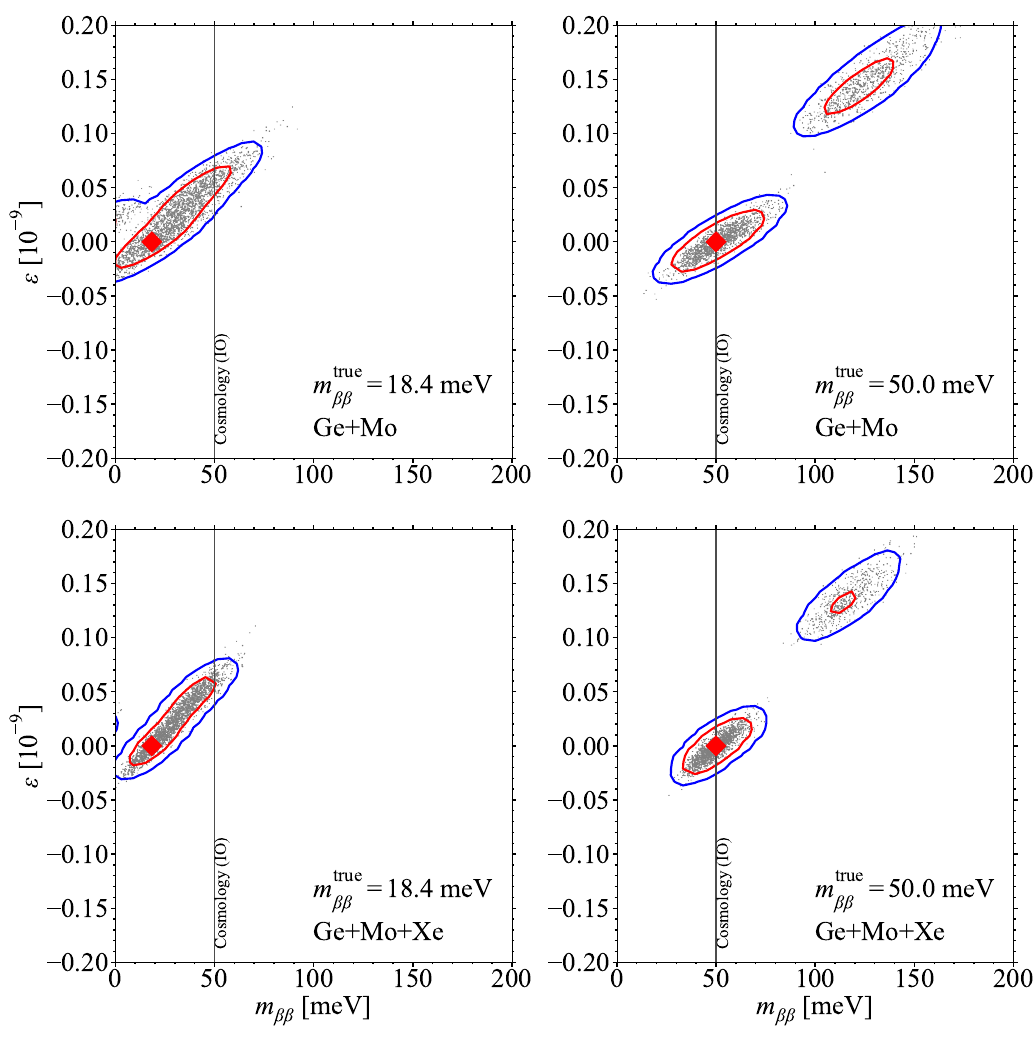
Figure 4 . As figure 3, but with reduced NME